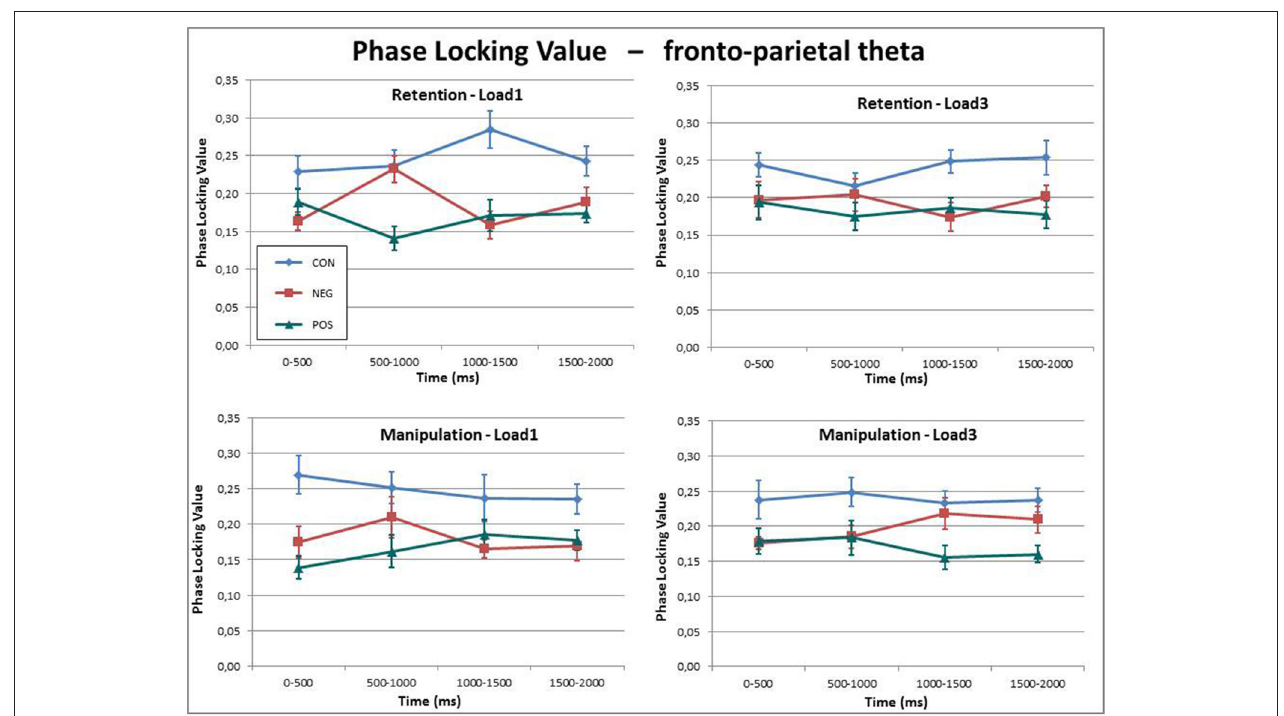
FIGURE 4 | Theta phase synchronization between the ACC and the BA40 indexed by phase locking values (PLVs) for all three groups in the four conditions over the delay period. While the phase synchronization is fairly constant over time and between conditions, the healthy control subjects display a generally higher phase synchronization than the two patient